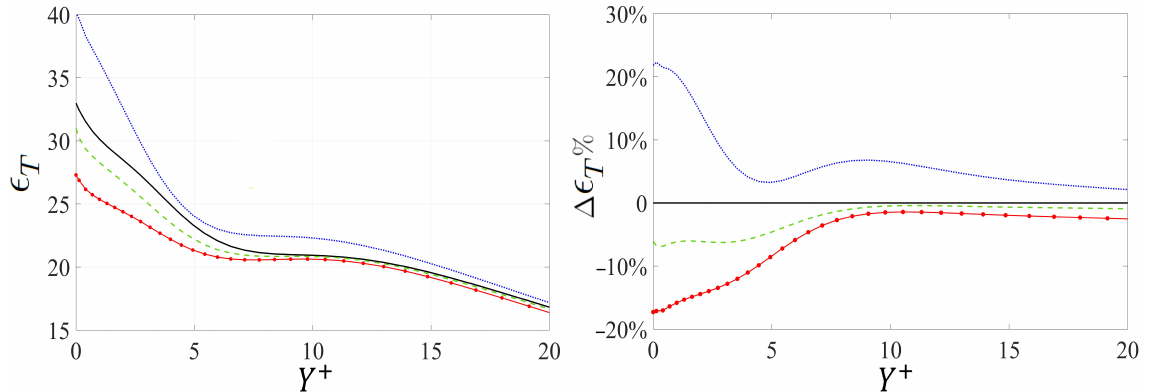
Figure 17. Distributions of the turbulent dissipation near the permeable wall for different configura- tions of the porous substrate, with the percentage deviations from the reference smooth surface case displayed in the right frame. Refer to Figure 14 for the definition of the symbols used.